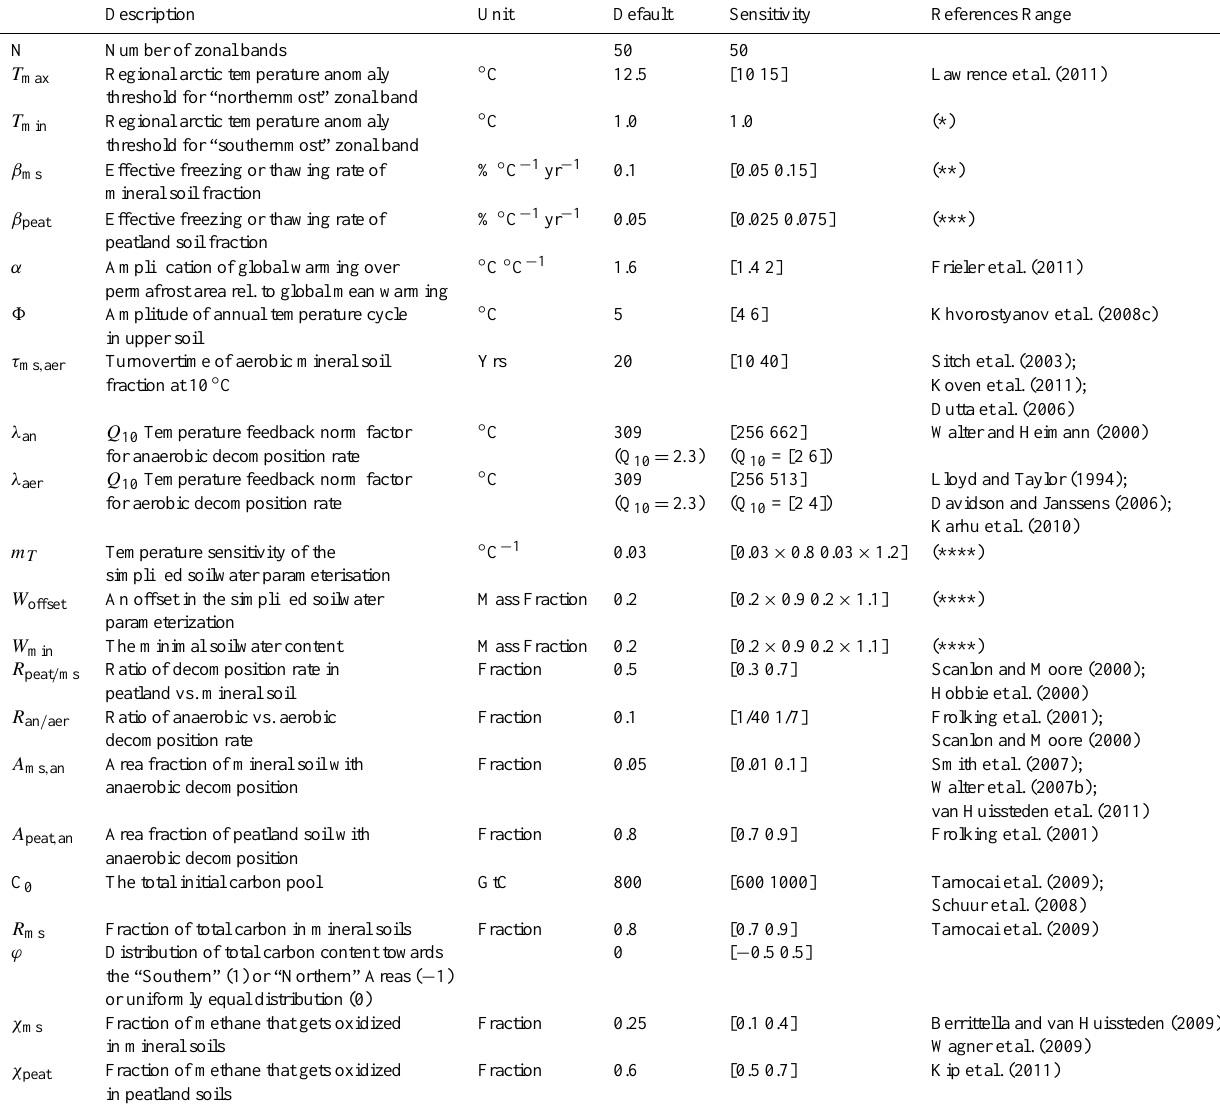
Table 1. Default and sensitivity range parameters of the permafrost module. Sensitivity ranges are sampled from a uniform distribution between the stated minimal and maximal value. When applicable, parameter ranges were inferred from or estimated based on published